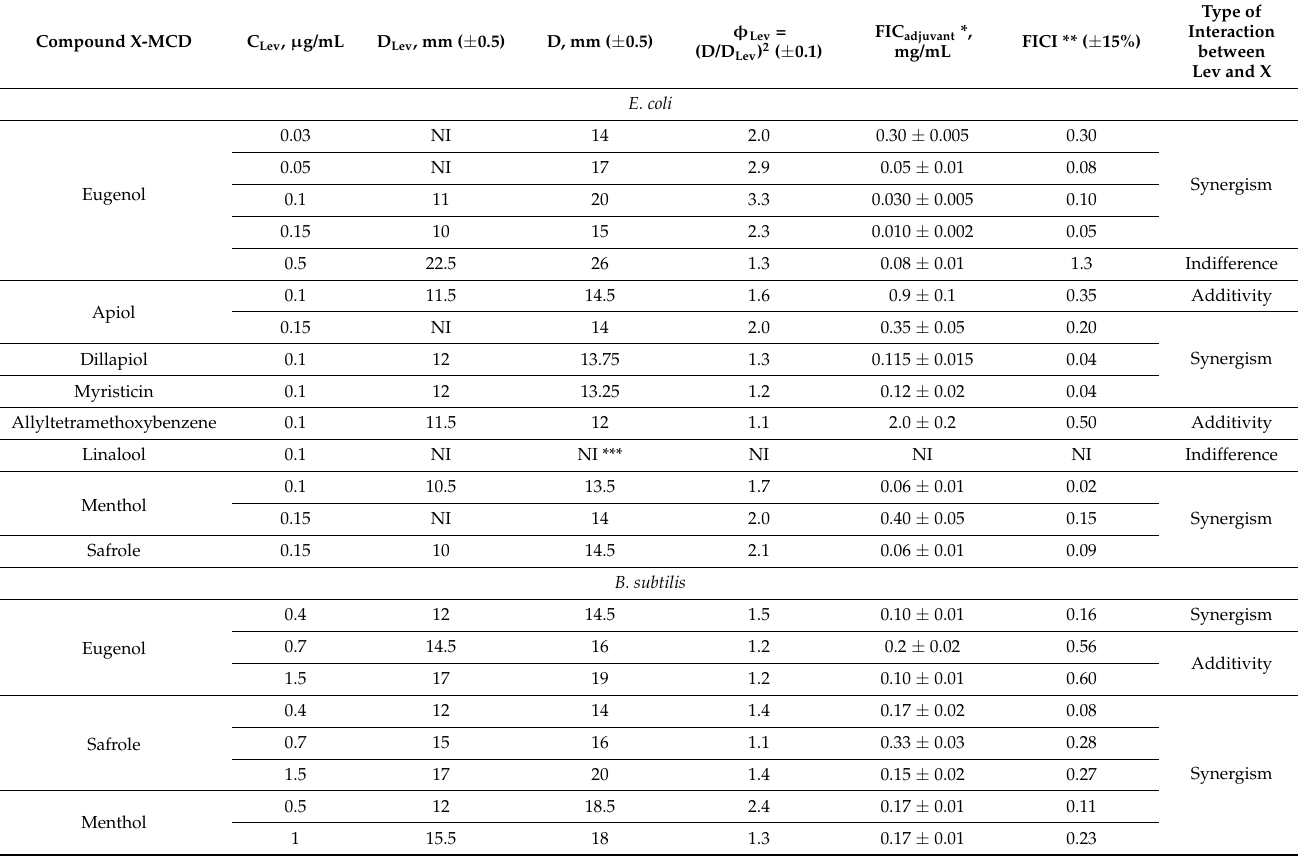
Table 4. Parameters of E. coli and B. subtilis growth inhibition by mixtures of Lev-MCD and adjuvant- MCD (1:2). D Lev and D—diameter of bacterial inhibition zone surrounding Lev–MCD and Lev–MCD with APAB-MCD, respectively. φ Lev —cooperative antibacterial action of APABs or terpenoids and Lev. The conditions and adjuvant concentrations are similar to those given in Table 3. Values are presented as the mean ± SD of three experiments.